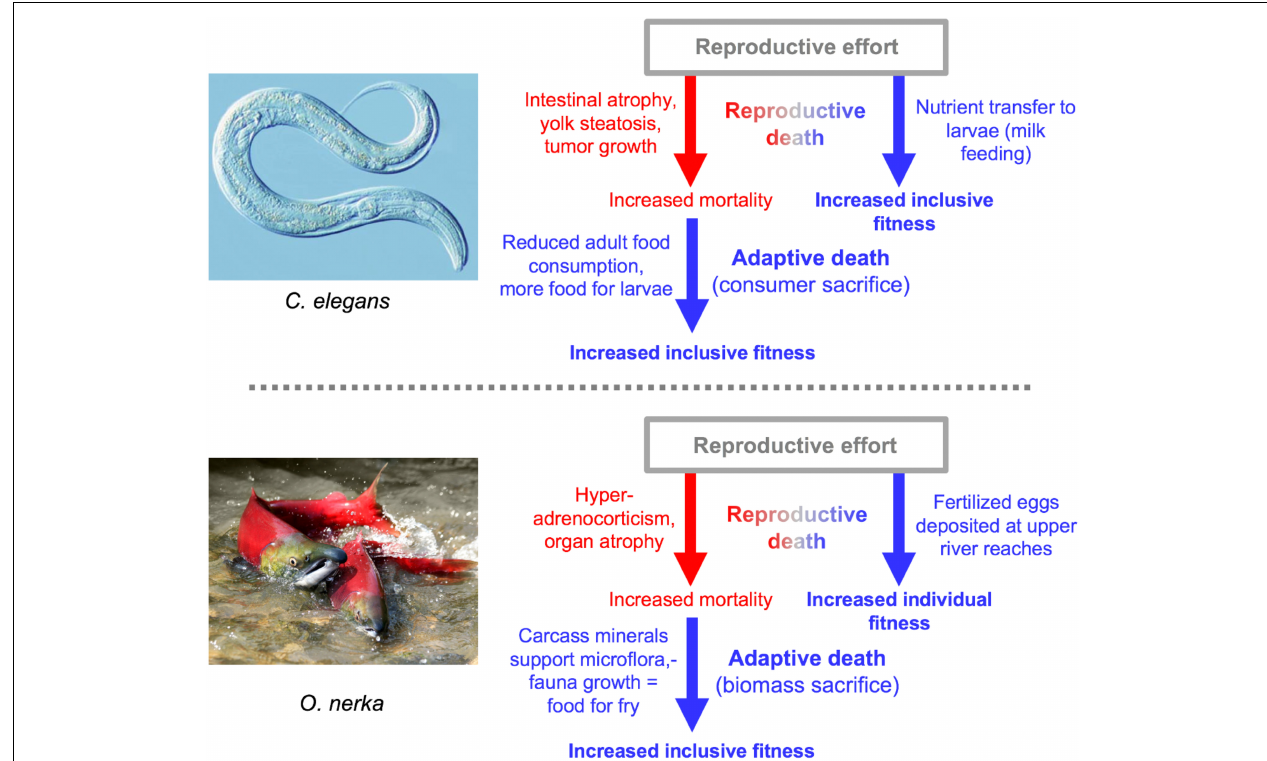
FIGURE 8 | Double death: Reproductive death and adaptive death combine to promote fitness. In both cases there is evidence for the existence of adaptive death, but its existence has not been definitively proven (Galimov and Gems, 2021). The two examples of double death differ in that adaptive death in C. elegans involves consumer sacrifice (removing a consumer to increase food availability for kin) while in O. nerka it involves biomass sacrifice (dying to facilitate resource remobilization) (Lohr et al., 2019).